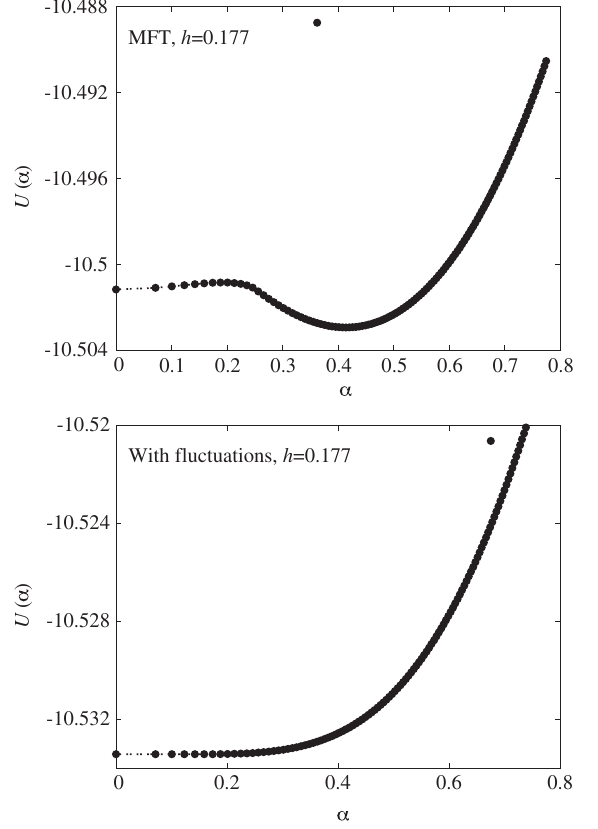
FIG. 7. Comparison of the zero-temperature potentials at the putative mean-field first-order transition (red cross at h ¼ 0 . 205 , T ¼ 0 in Fig. 3). Mean-field theory (top) incorrectly predicts a first-order transition to a phase-separated fully gapped BCS plus excess fermion state with a second minimum at α 0 ¼ 0 . 41 degenerate to the α 0 ¼ 0 one, the former overshadowing the Fermi surface mismatch. Fluctuations (bottom), however, sup- press the ordering tendencies and instead yield a symmetric state with α 0 ¼ 0 . The other initial parameters are the same as in Fig.